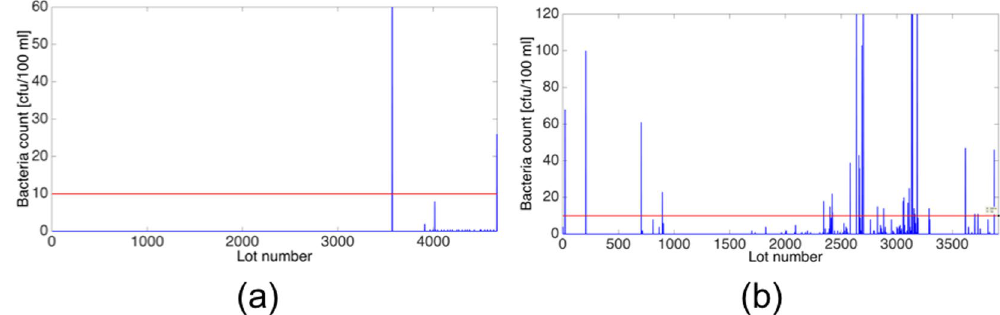
Figure 5. Fecal Coliform Counts. ( a ) Non-action time series acquired in Machane Yisrael well between March 2001 and December 2013. In this time period the well was sampled 107 times with an average time between samples of 44 days; ( b ) Action time series acquired in Rosh Hayin 4 well between April 2001 and January 2011. Throughout this time period Rosh Hayin 4 well 212 counts were performed with an average 19 days between